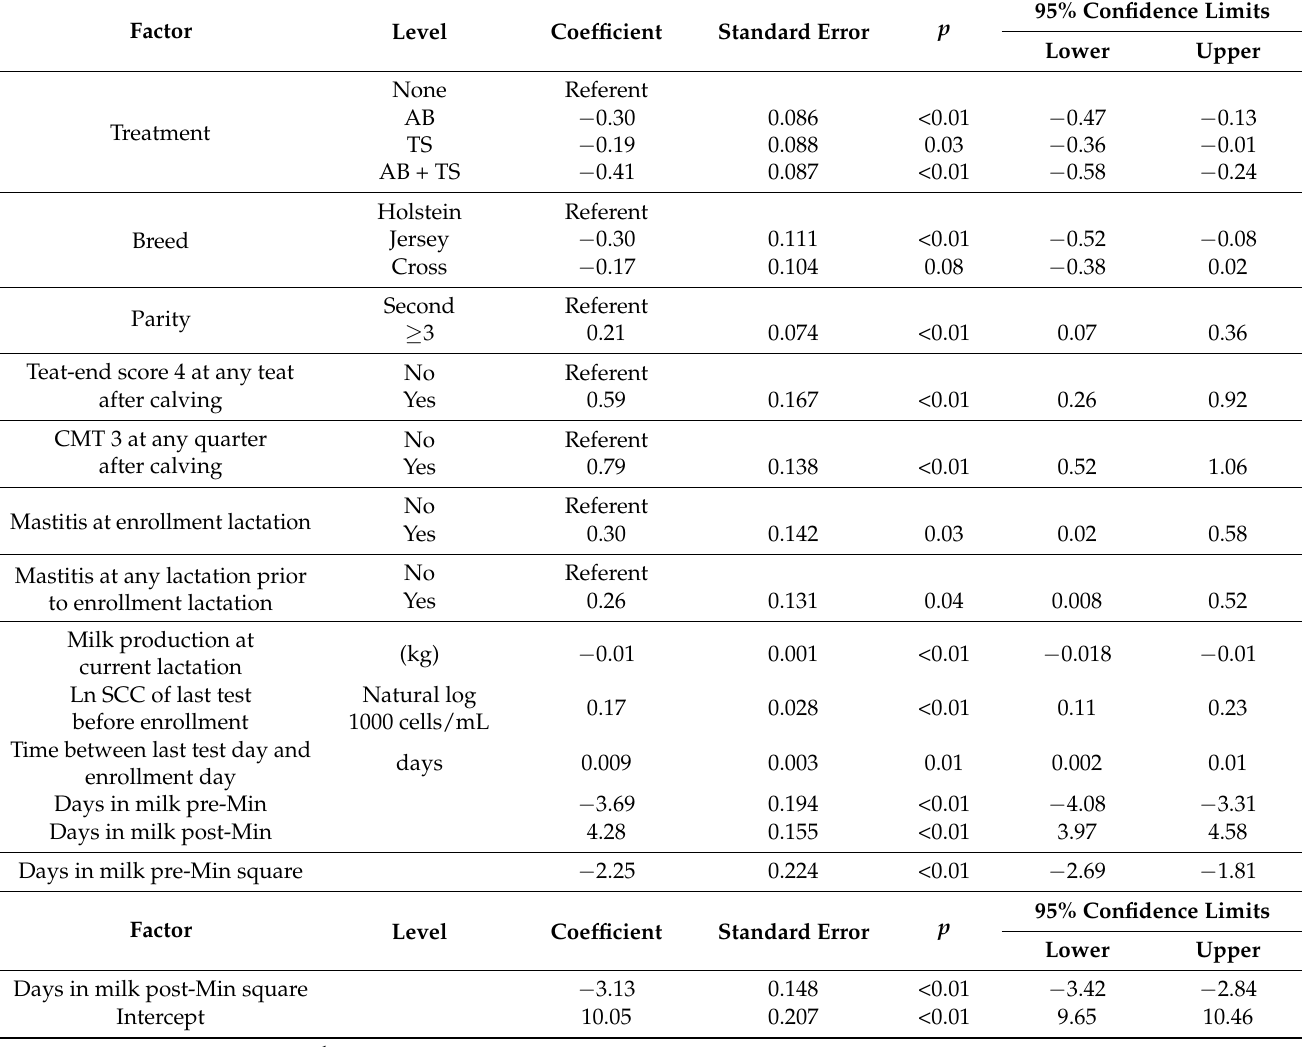
Table 4. Final two-piece spline models for natural logarithm-transformed test-day somatic cell